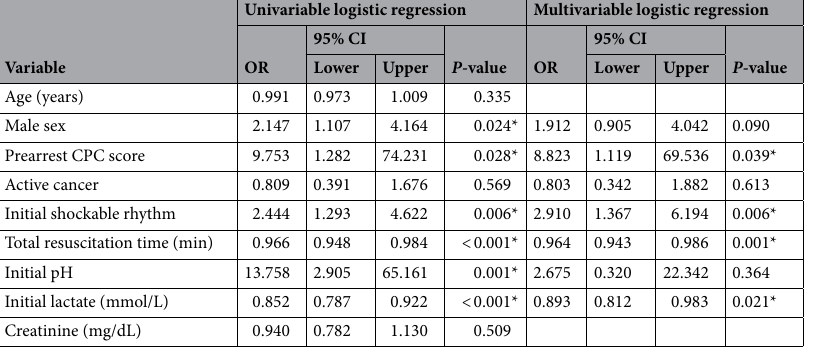
Univariable logistic regression Multivariable logistic Variable